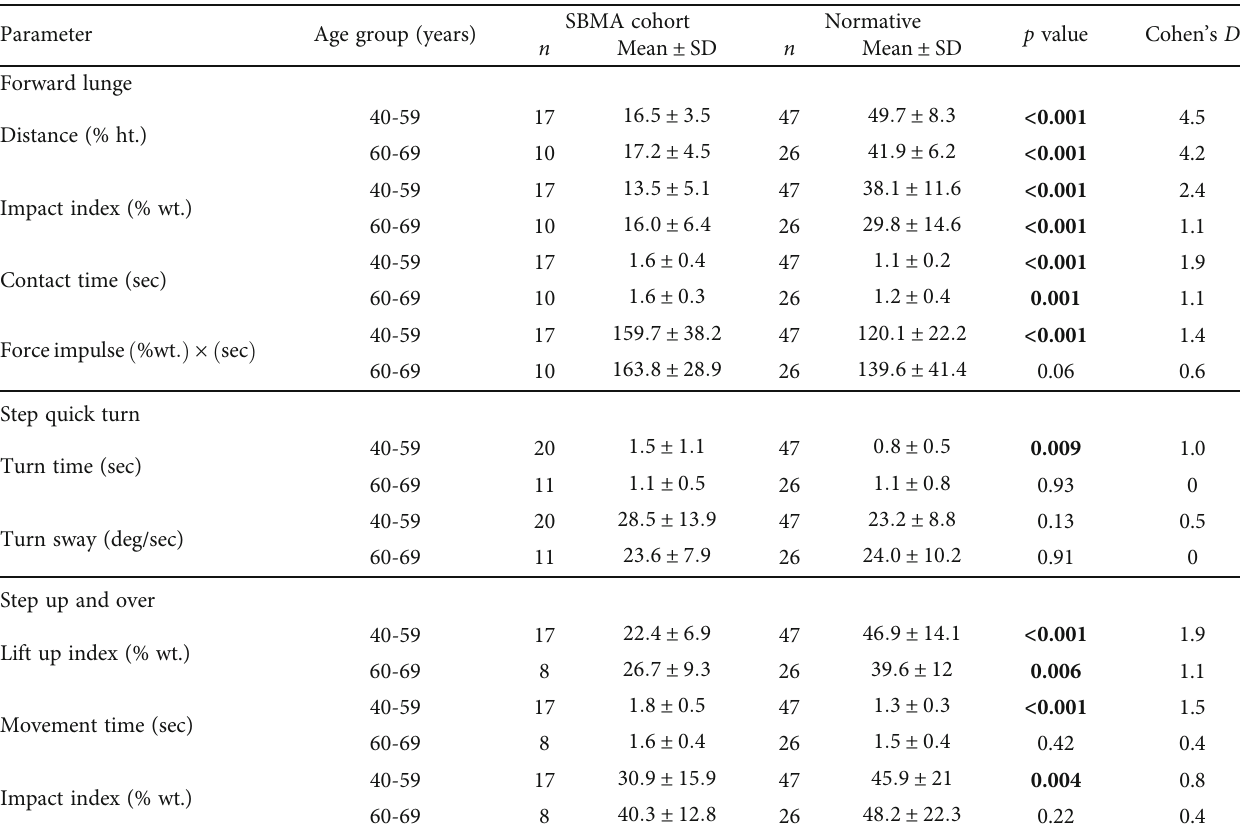
Table 1: Comparisons between SBMA cohort and NeuroCom normative references on forward lunge, step quick turn, and step up and over tests. Right-sided data are